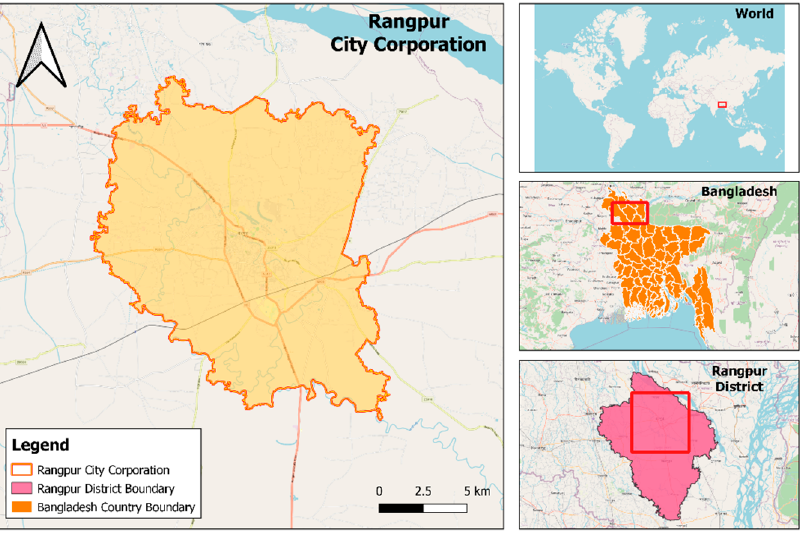
Figure 1. Location map of Rangpur division and city in the context of Bangladesh. Authors’ illus- tration.